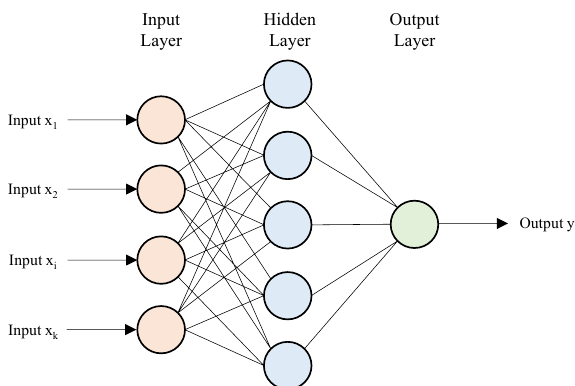
Figure 4. Sketch of the MLP